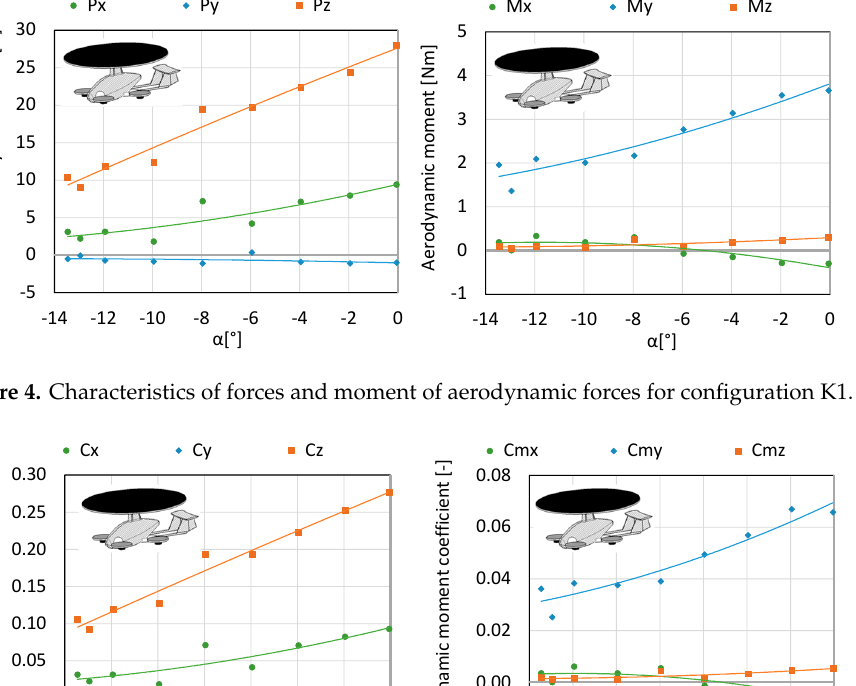
Figure 4. Characteristics of forces and moment of aerodynamic forces for configuration K1.